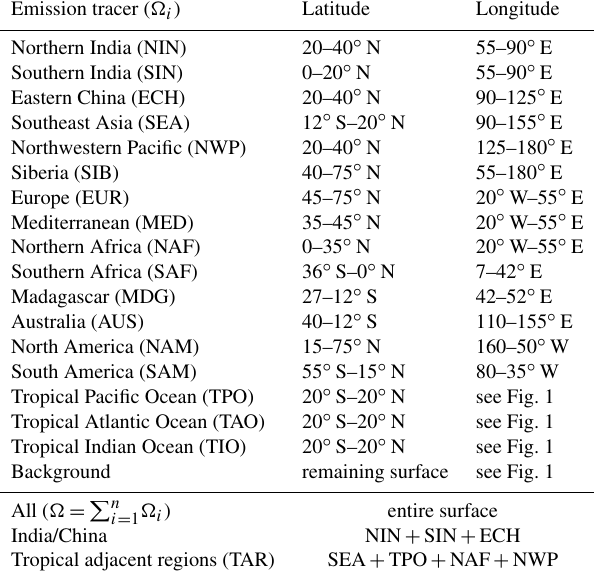
Table 1. Latitude and longitude range of artificial boundary layer sources in the CLaMS model, also referred to as “emission tracers”. The geographical position of each emission tracer is shown in Fig. 1 (adapted from Vogel et al., 2015,